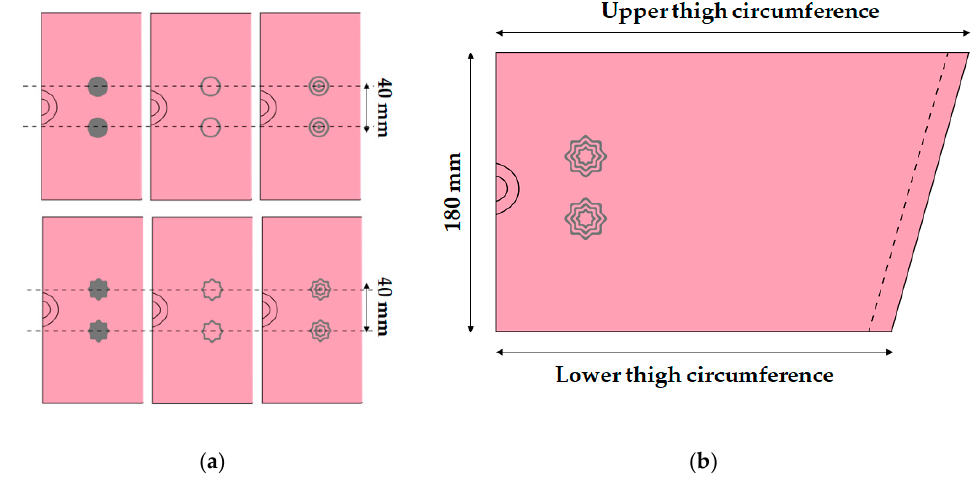
Figure 2. Scheme of fabrication of leg sleeves with embedded embroidery electrodes: ( a ) IED (inter-electrode distance) and ( b ) pattern image of sample.